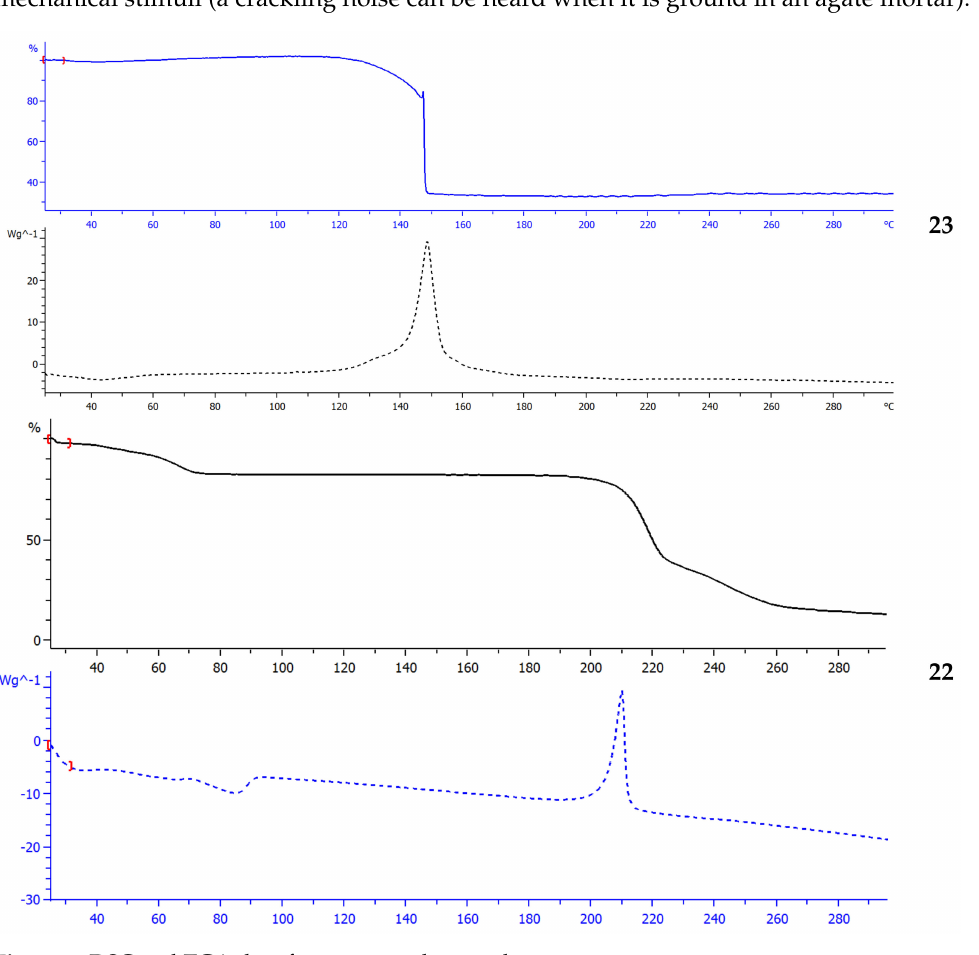
Figure 3. DSC and TGA data for compounds 22 and 23